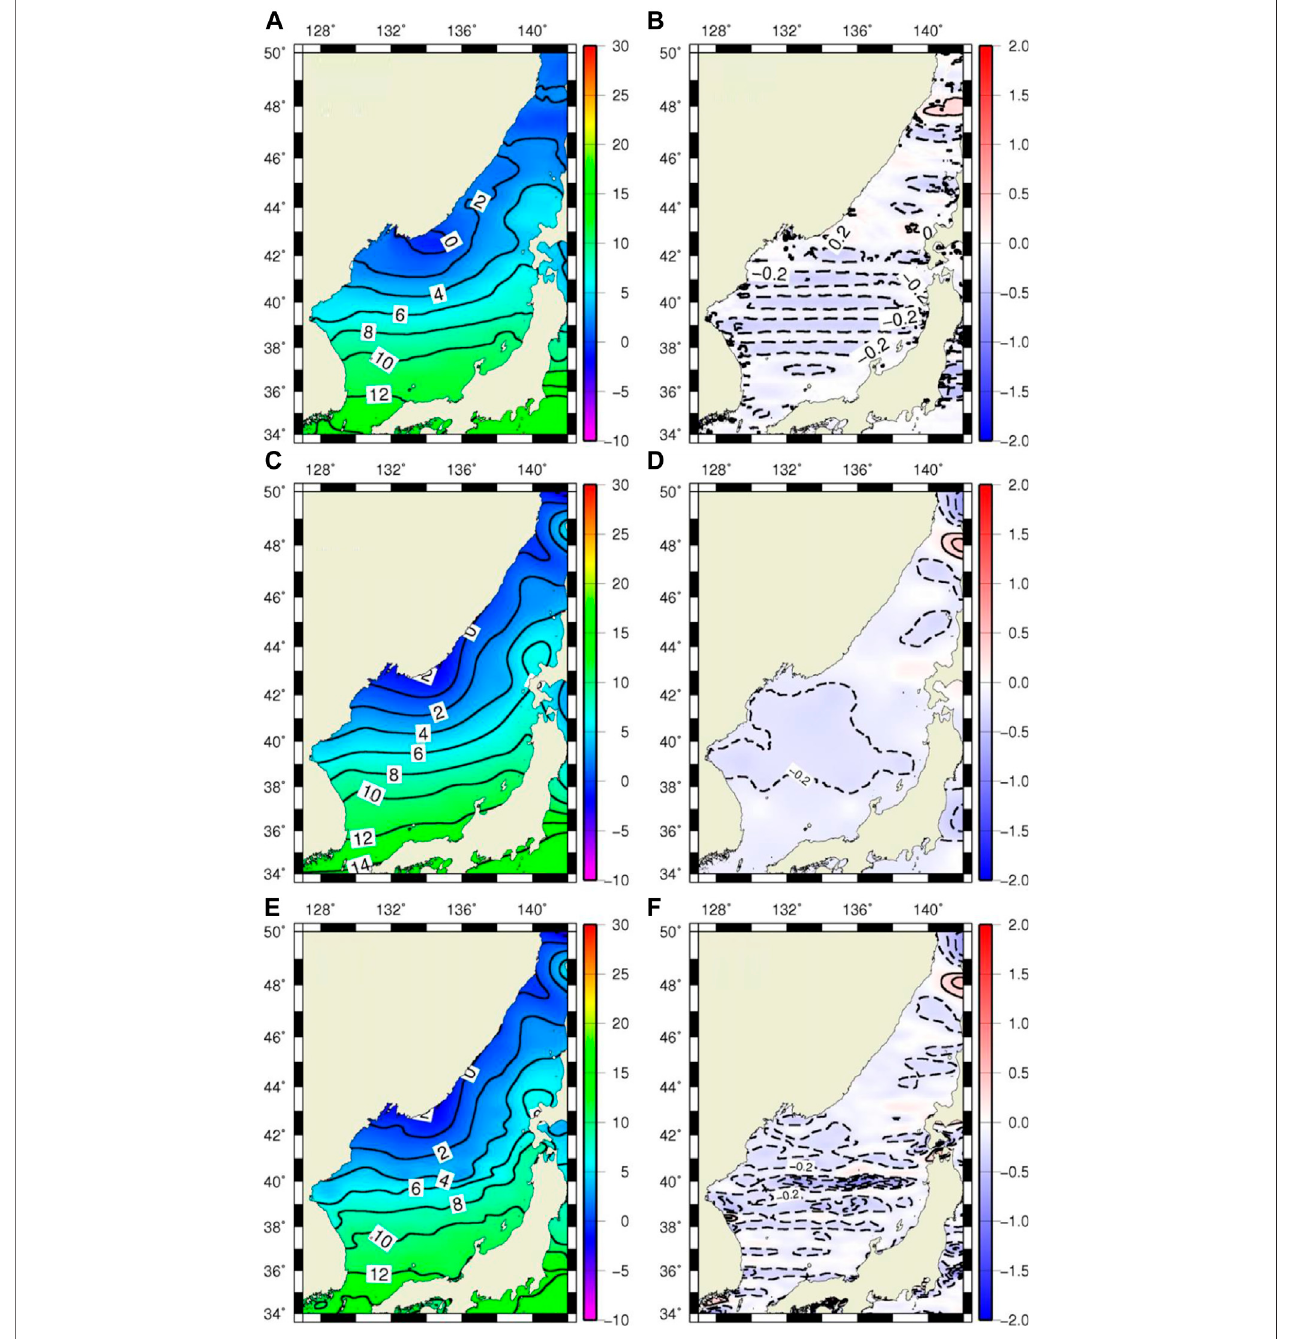
FIGURE 4 | The same as Figure 3 except for (A, B) only 1 ° gridded WOA13, (C, D) only linear interpolated 0.1 ° WOA13, and (E, F) both 0.1 ° gridded WOA13 and irregular WOD13.